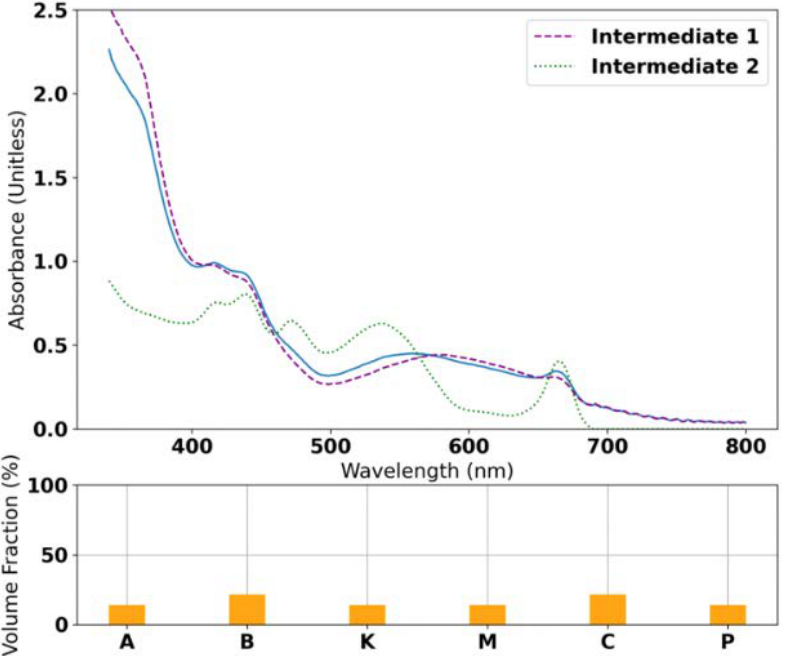
Figure A3. In addition to the 50/50 Betalin/Chlorophyll profile, the RBF interpolation scheme can be forced to proceed through an arbitrary number of data points. For example, in Figure A3, the predicted absorbance profile has been forced to fit the empirical UV-Vis data for the ABKMCP combination as well. This highlights one major advantage of the RBF method, which is that the model’s error can be lowered to an arbitrary small degree simply by collecting and including more empirical data in the data matrix of Equation (1). (Download the supplementary materials to review this animation).